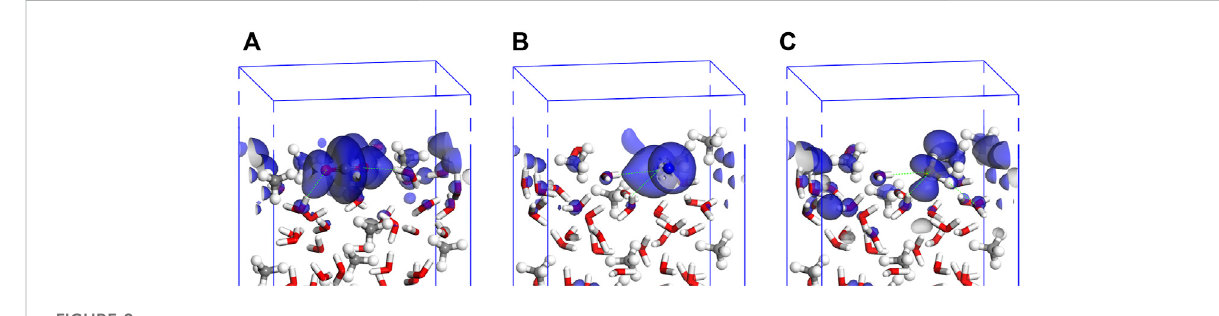
FIGURE 8 Interfacial electronic orbitals of absorbed CO 2 (A) , N 2 (B) , and H 2 S (C) on MH(001) surface (energy level range: − 1~1